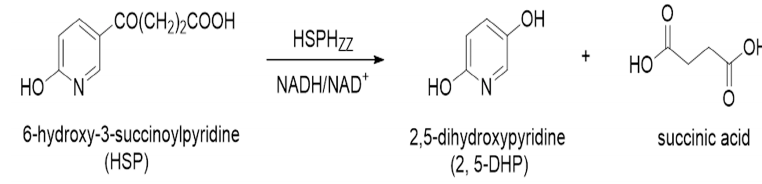
Figure 2. Enzymatic production of 2,5-dihydroxypyridine (2,5-DHP) from HSP catalyzed by the nicotine hydroxylase HSPH ZZ .